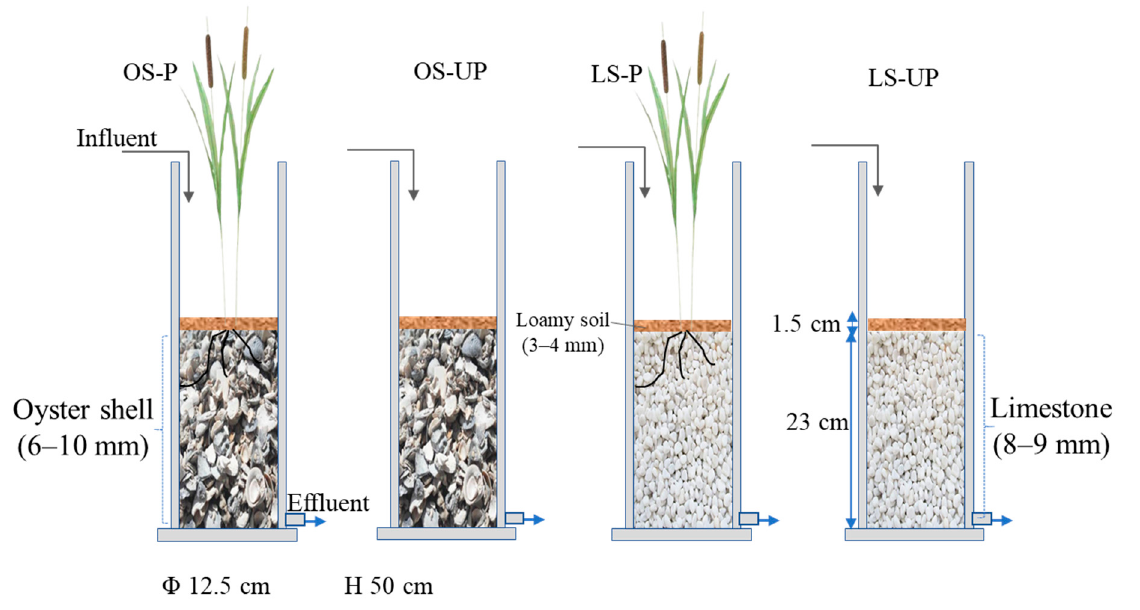
Figure 1. Diagram of lab-scale CWs filled with oyster shells (OSs) / limestone (LS) and unplanted (UP)/planted (P) with cattails.